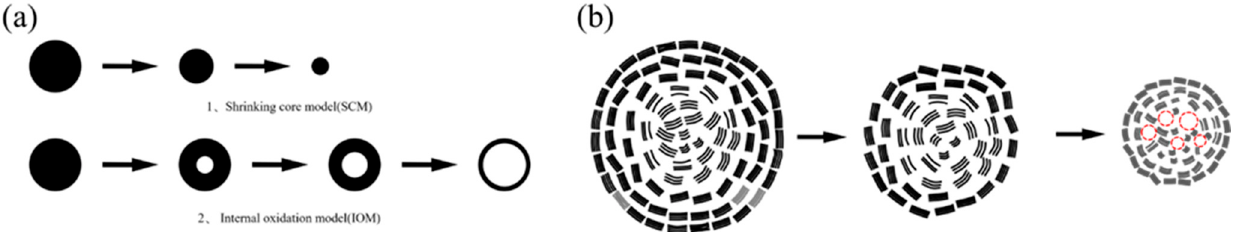
Figure 8. ( a ) Schematic diagram of oxidation model; ( b ) diagram of soot oxidation model. Devel- oped from [21].